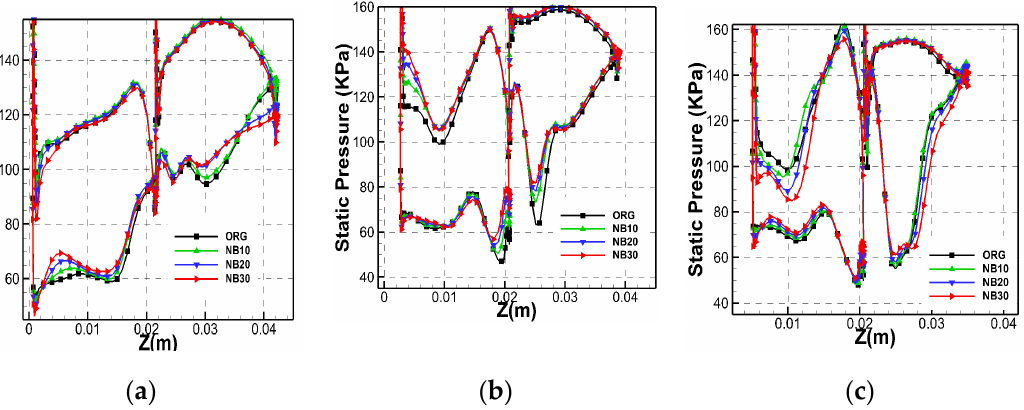
Figure 10. the contrast diagram of surface static pressure distribution at different spans of NB10, NB20, and NB30. ( a ) 10% span. ( b ) 50% span. ( c ) 90% span. Figure 11 shows the comparison of static pressure and the limit flow line diagram on the suction surface of NB10, NB20, and NB30. There are obvious separation lines at the hub and middle of the suction surface of ORG, and the separation line extends from 10% to 60% of the blade spread. The separation line is generated by boundary layer separation caused by shock waves. The negative bow blades increase the boundary layer separation range in hub region of front blade, and the separation line caused by shock waves extends